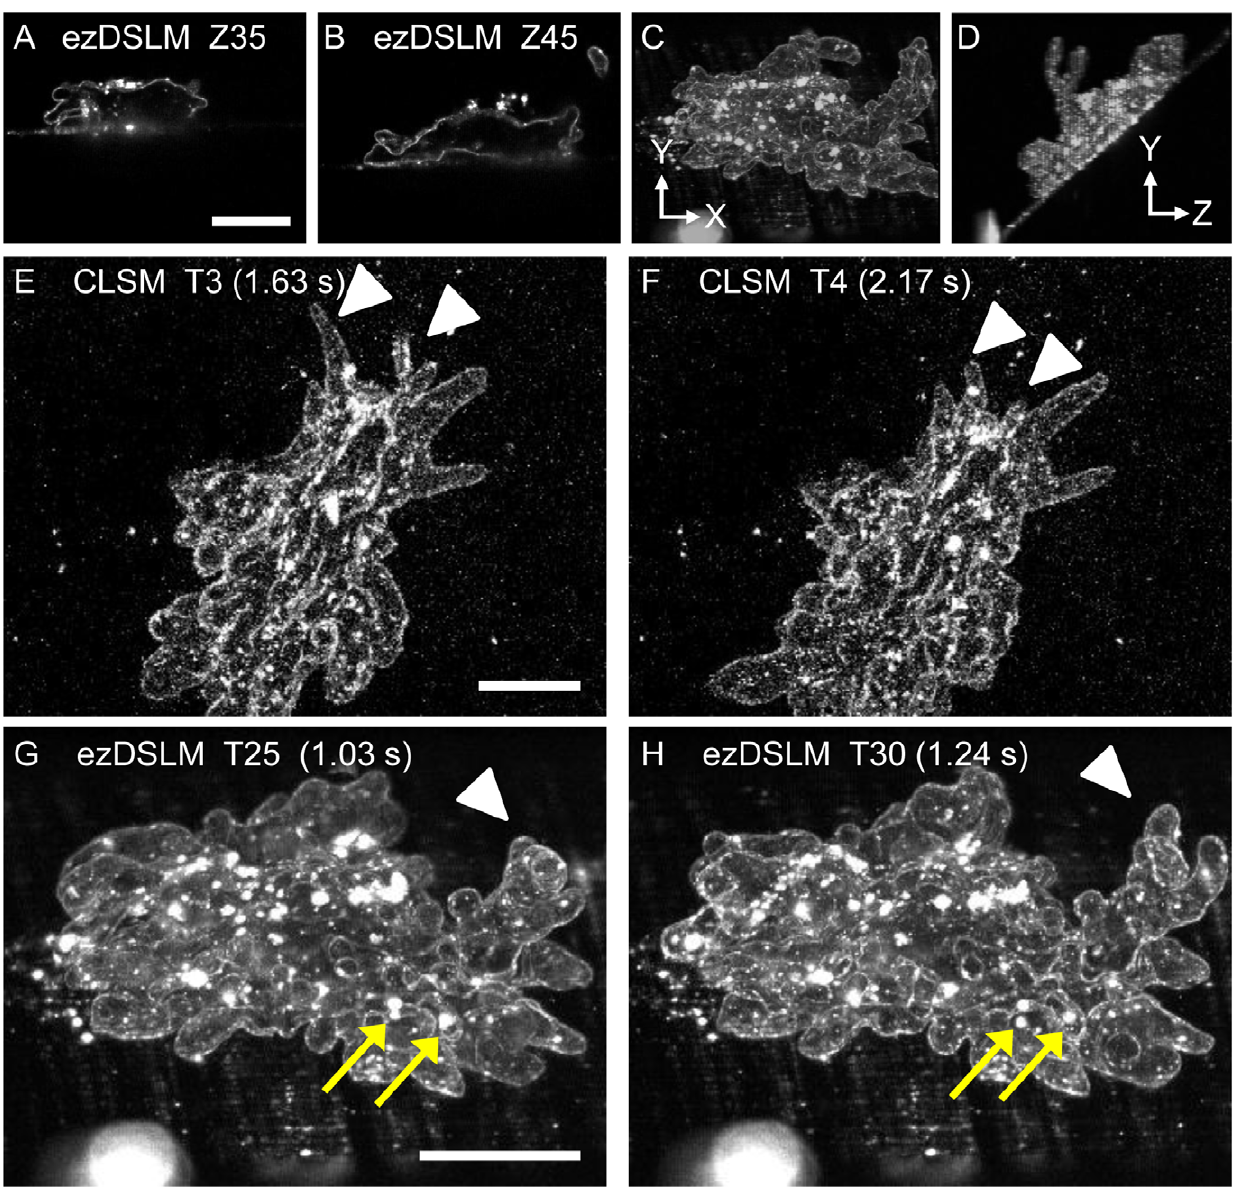
Figure 3. Images of freely moving DiI-labeled amoebae. Images were obtained using the ezDSLM (A–D, G, H) and CLSM (E, F). (A, B) X–Y optical sections from a Z-stack. Z35 and Z45 indicate slice numbers in Z-stacks with 2.48 m m intervals, i.e., actual distances are 86.8 and 111.6 m m, respectively. A complete series of Z-stack is shown in Fig. S2. (C, D) Front (C) and side (D) views of a reconstructed three-dimensional image. (E, F) Max projection images of Z-stacks at time-points T3 (E) and T4 (F) from time-lapse images obtained using CLSM. Intervals for each time-point were 0.54 s. It is difficult to follow the changes in shapes (arrowheads). (G, H) Max projection images from Z-stacks at time points T25 (G) and T30 (H) from time- lapse images obtained by ezDSLM. Intervals for each time-point were 0.04 s. Extensions of protrusions (arrowheads) and traceable clusters of dye (arrows) are depicted in detail. Note that the four more images (T26–T29) are present between these time points (not shown). Scale bars, 50 m m.